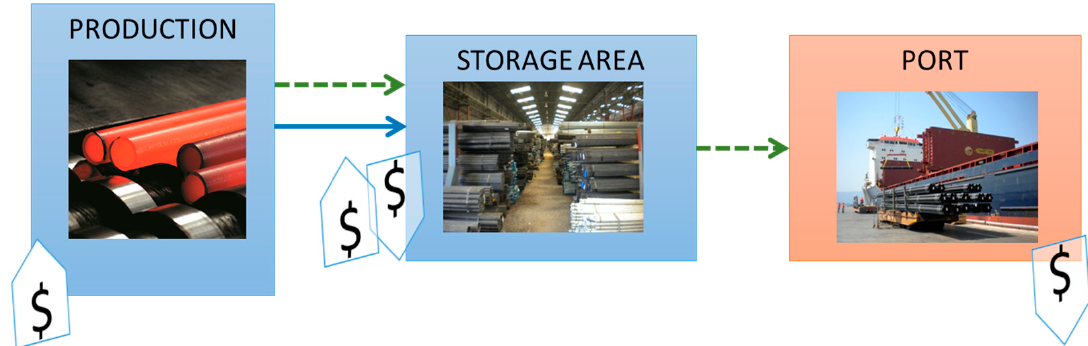
Figure 1. The vessel loading process.